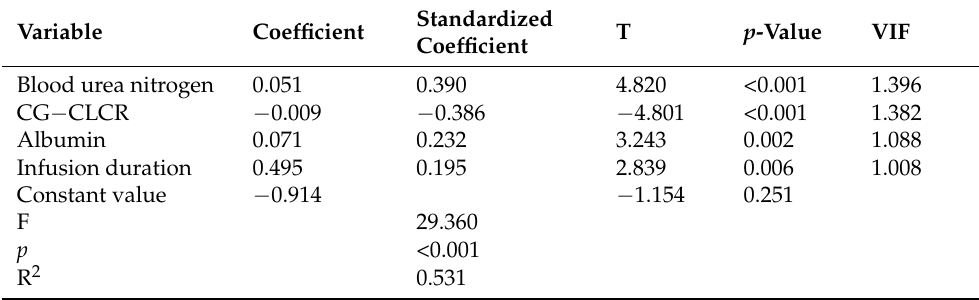
Figure 2. Correlation analysis between ln (C trough ) and its determinants ( A ) blood urea nitrogen, ( B ) CG-CLCR endogenous creatinine clearance rate and ( C ) albumin. Table 3. Multiple linear regression analysis of meropenem concentration determinants .